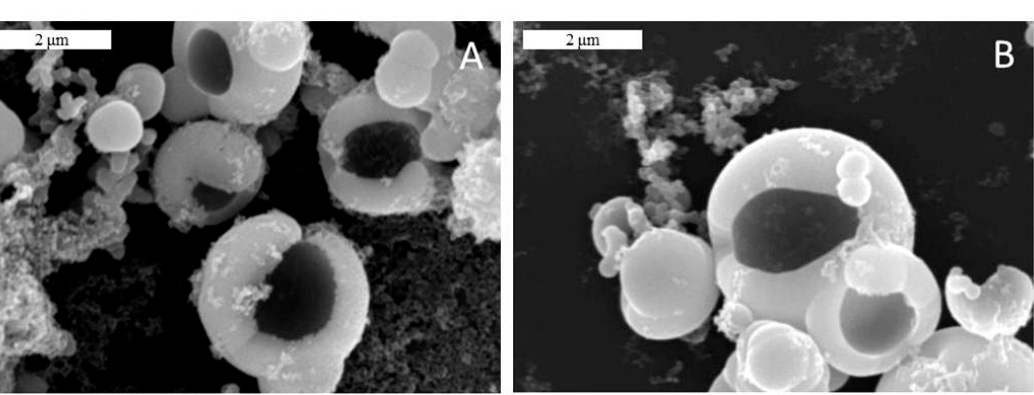
Figure 9 . Particle degradation study. ( A , B ) Scanning electron micrographs of emulsion-based core- shell microcapsules after being exposed to a pH 6.8 nanopure water for 2 min, and ( C , D ) after exposure to a pH 4.0 HCl solution for 15 s. The rounded and particulate character of the remaining shells may be showing a memory effect of the PILP droplets that had initially coalesced to form the shells. 4. Discussion The morphologies observed by optical and scanning electron microscopy (SEM) demonstrate that this biomimetic PILP process leads to a smooth, and continuous mineral shell that has formed a thick coating around the liquid-like particles. Importantly, SEM also demonstrates the robustness of core–shell particles when subjected to storage in ethanol, centrifugation, and air-dry storage. This suggests that these core-shell suspensions may be dried down to a powder and retain core-shell integrity. Using polarized light microscopy (PLM), we demonstrate the possibility of controlling the phase of the CaCO 3 shell (i.e., crystalline vs. amorphous). Control over the final phase could be a means to tailor the degradation properties of the microcapsules since amorphous calcium carbonate is metastable and far more soluble than the crystalline form. The core-shells’ ability to entrap and protect active agents is demonstrated by the confocal microscopy results shown in Figures 7 and 8. This data allows one to discern between fluorescence originating from within the microcapsule and fluorescence originating from within the CaCO 3 shell or surrounding solution. Nile Red has the useful property of fluorescing only in very hydrophobic environments. Although it is conceivable that a small portion of the model compound could become entrapped within the mineral shell itself, the fluorescence seen in Figure 7 indicates that the interior of the microcapsules indeed contains the stored model agent. The results also show that the generated microcapsules retain the active agent even under the stress of centrifugation and resuspension in anhydrous ethanol. The presence and overlap of fluorescence originating from both oil soluble Nile Red and water-soluble rhodamine 110 (Figure 8C) demonstrates that the liposome-derived core-shell microcapsules can simultaneously entrap very different compounds in a single liposome-based microcapsule. Finally, the possibility of